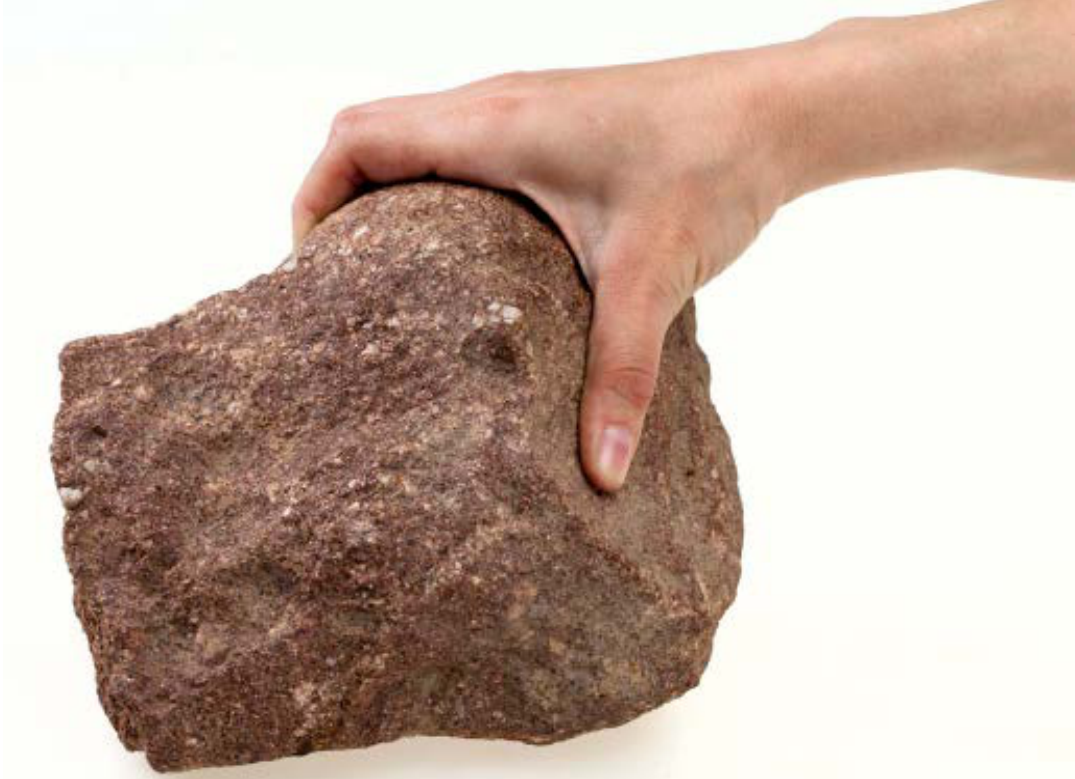
Figure 6. View of quern stone RLT 1-9 with a lateral grips serving to grip the tool (photo: Fr. Schneikert,